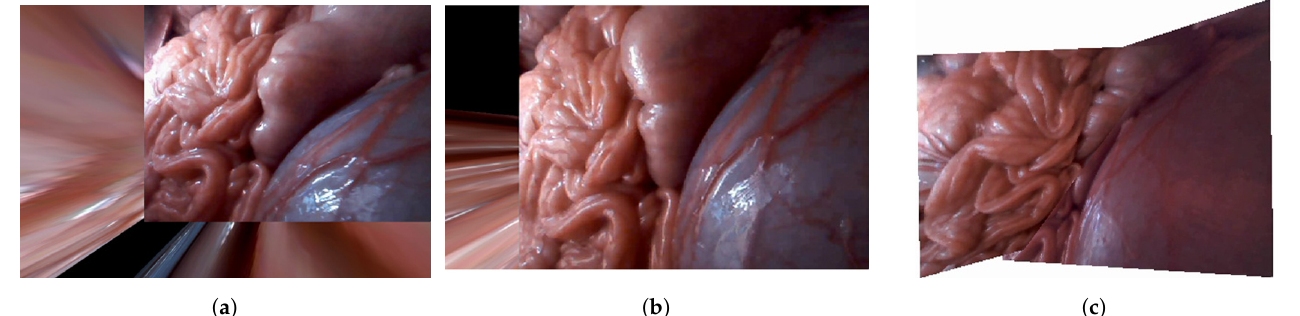
Figure 17. Results of in vivo experiment: ( a ) the results of the conventional approach, ( b ) the results of the hybrid tracking and mosaicking approach and ( c ) the results of the proposed